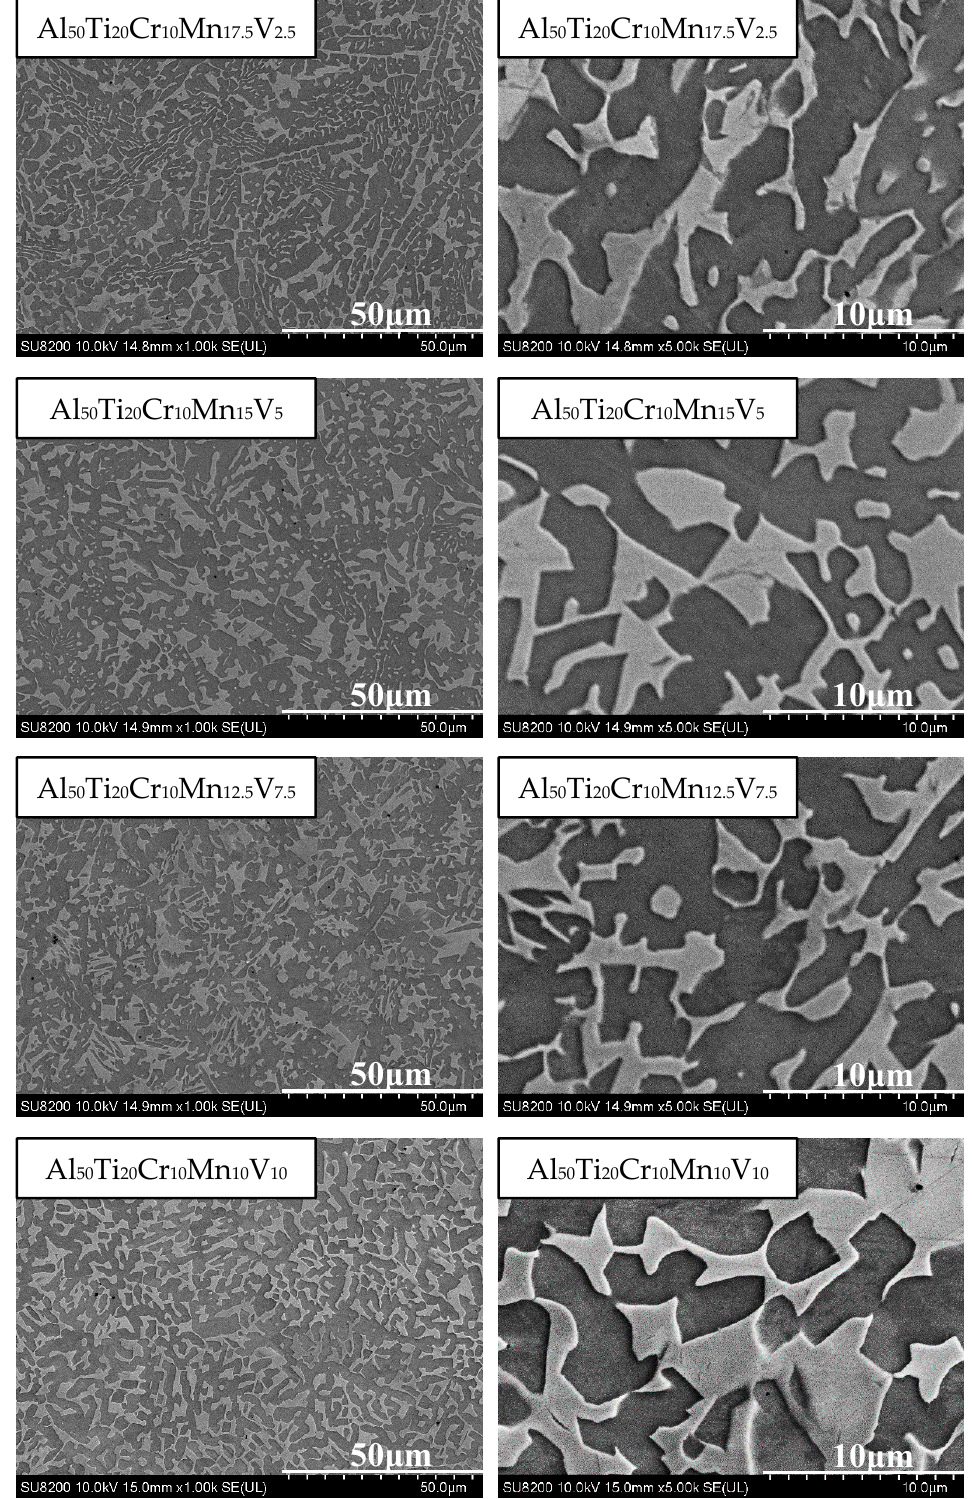
Figure 11. SEM images of the Al 50 Ti 20 Cr 10 Mn 20-x V x (x = 2.5, 5, 7.5, 10) alloys.